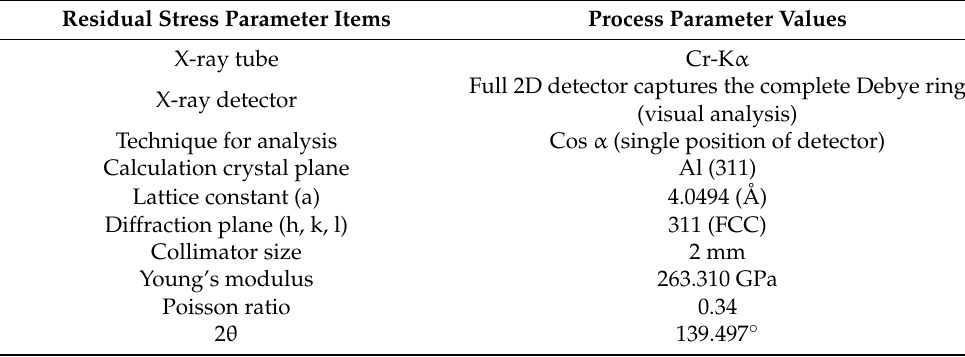
Table 4. Residual stress measurement